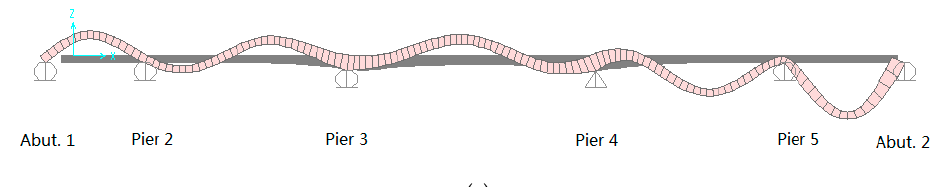
Figure 12. Longitudinal Mode Shapes from Finite Element Method (FEM) Analysis. ( a ) Mode 1 (1.584 Hz; Modal Participating Mass Ratios 0.10); ( b ) Mode 2 (4.348 Hz; Modal Participating Mass Ratios 0.17); ( c ) Mode 3 (5.060 Hz; Modal Participating Mass Ratios 0.18).